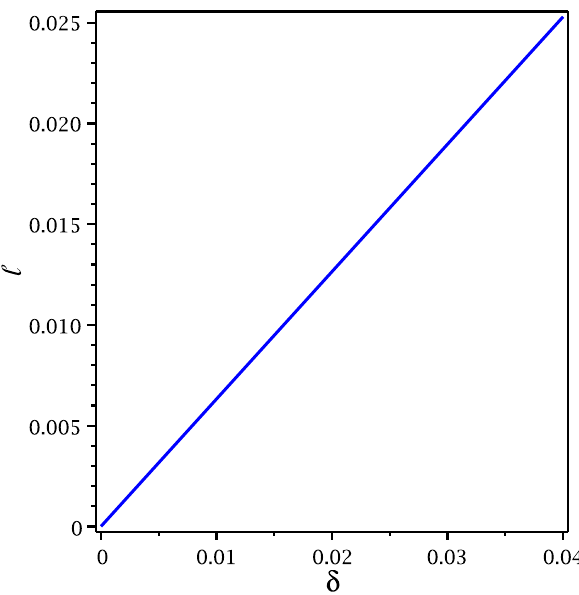
Fig. 4 The proper length l vs thickness δ . We have chosen σ 0 = 4, Fig. 5 The proper length l vs radius D . We have chosen σ 0 = 4,